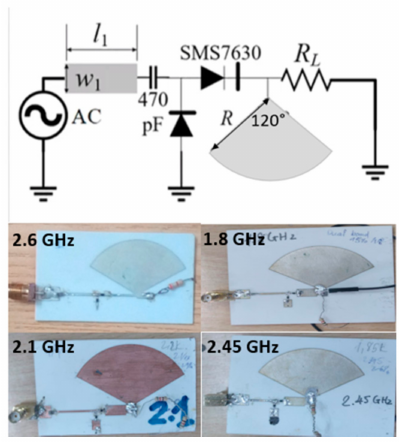
Figure 11. Schematic and fabricated rectifiers.